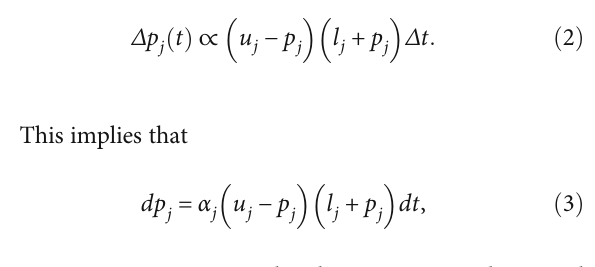
ð ̂ m ð ̂ m , k Þ , β , k Þ , and β k k 1 2